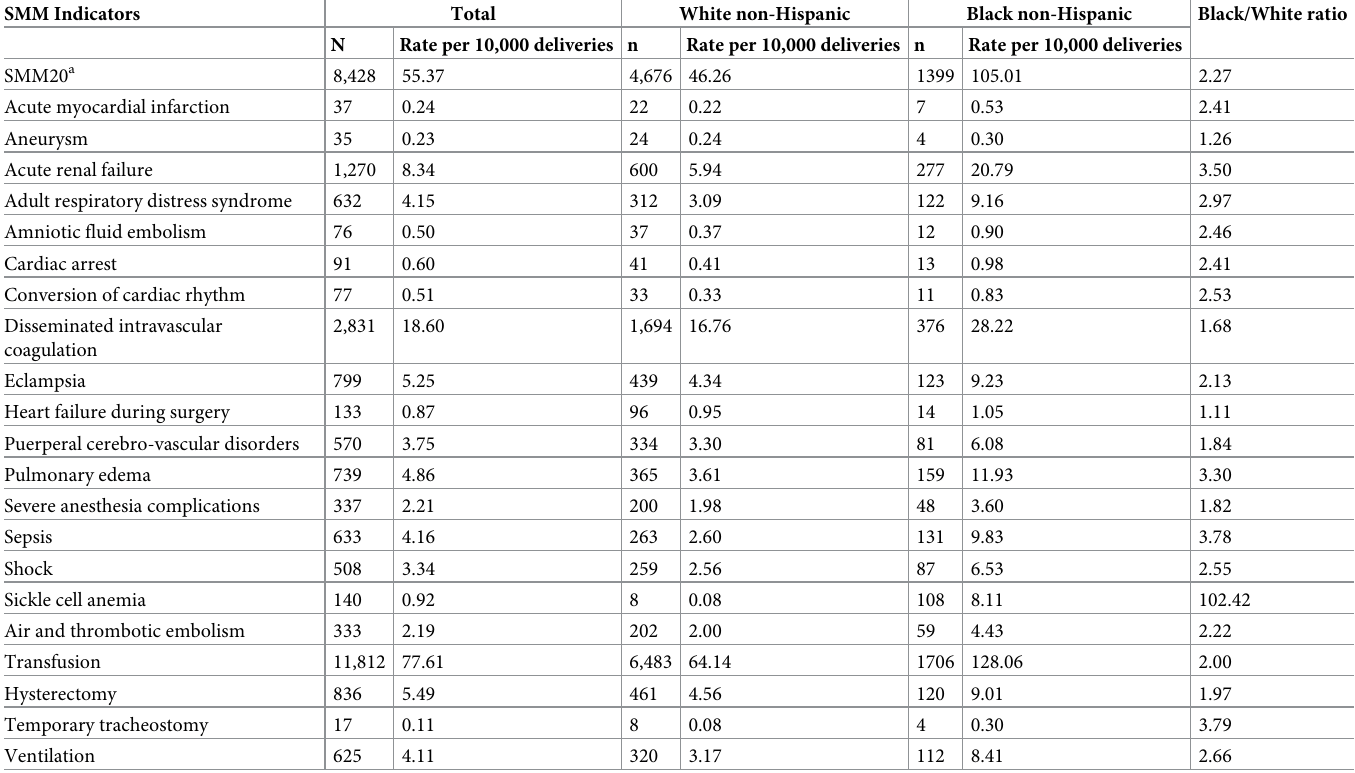
Table 1. Severe maternal morbidity a indicators for White non-Hispanic and Black non-Hispanic birthing people: Massachusetts January 1, 1998-December 31,